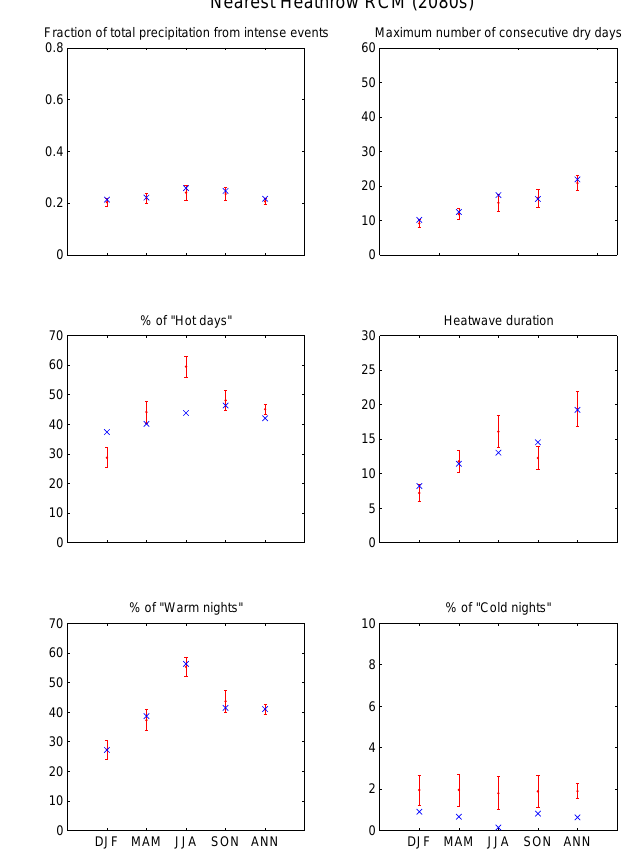
Fig. 4. RCM 2080s scenario (HadRM3Q0 – blue, shown as crosses) and simulated (red dots and error bars) extremes for each half month for the grid cell nearest Heathrow based on a 30yr period (1961– 1990). The simulated values are the means of 100 weather generator runs. The lines and bars show the variability of the 100 runs (plotted as plus/minus two standard deviations around the